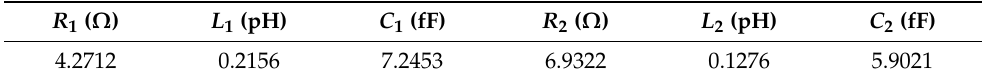
Figure 7. ( a ) The equivalent RLC circuit model of the hybrid graphene-Nb coupled resonators. ( b ) THz transmission and frequency tuning of the hybrid SRR for different graphene conductivities between σ 0 = 0 and σ 0 = 2.5 mS obtained using the equivalent RLC model. Table 1. The circuit parameters for lower and upper